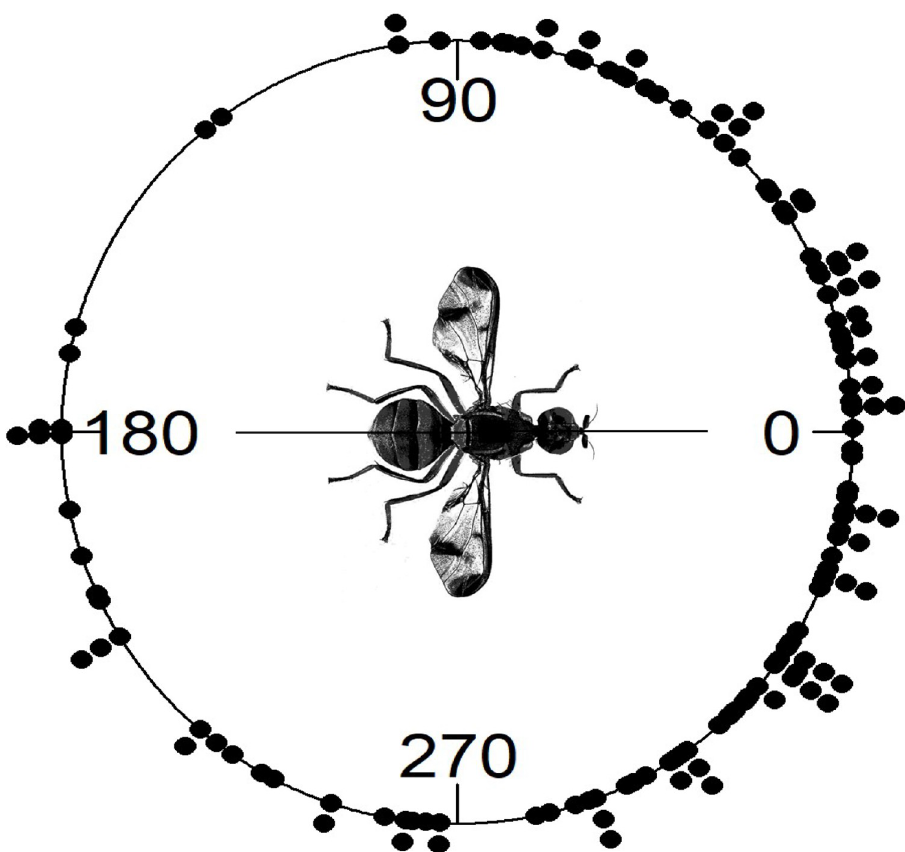
Fig 8. Combined turning angles of HR tagged Zeugodacus cucurbitae for experiment 4 (papaya). A turning angle of zero indicated that a fly flew in the same direction as the directly previous flight. Combined turning angles were non-random ( � R � = 0.419, P < 0.001, Rayleigh test, P = 0.001, Hermans-Rasson test), showed no right-left bias ( P = 0.735, chi-squared test), but showed a pronounced “forward” movement bias ( P < 0.001, chi-squared test).